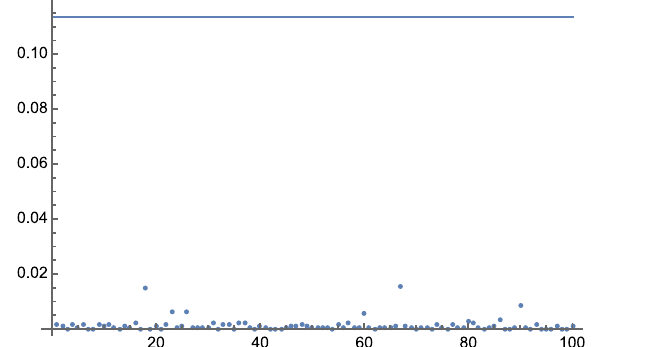
Fig. 6 The variances V [ F ] of Example 2 computed for 100 independent executions with 4 Newton–Raphson iterations for the Kullback–Leibler divergence exploiting 50 samples in each iteration. The horizontal lines correspond to the optimal and the equal sampling budget variances, respectively